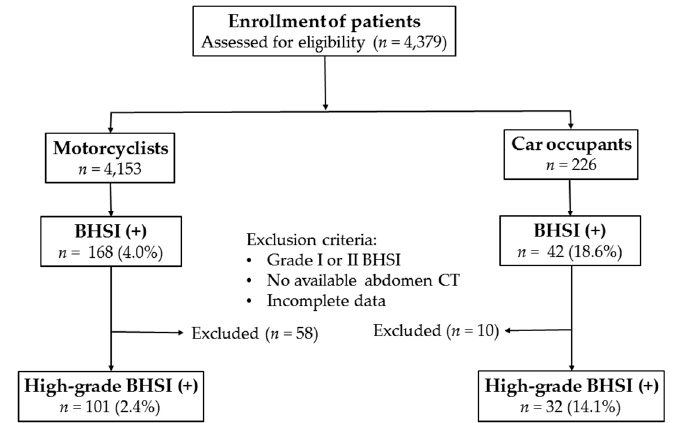
Figure 1. Flow chart of the studied patients with blunt hepatic and/or splenic injuries (BHSI).